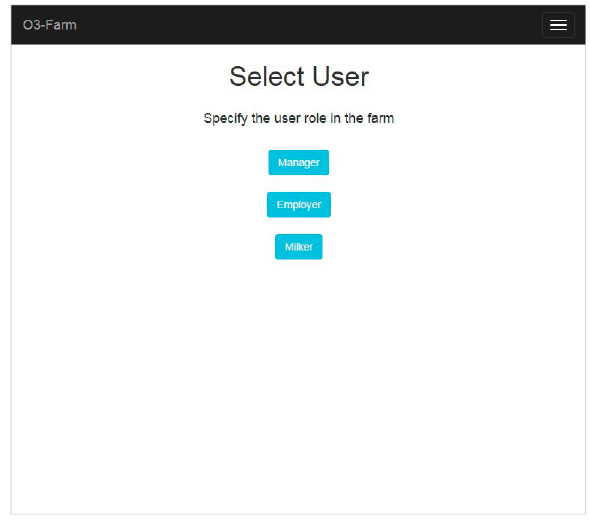
Figure 1. User-group-selection page.